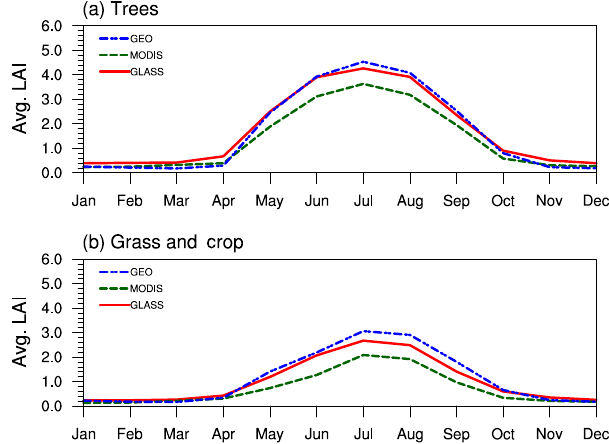
Figure 5. The monthly average leaf area index (LAI) values of (a) trees and (b) herbs in the three LAI products. Table 4. The simulation experiment configurations. E1 is the base- line experiment, and E1–E3 were used to investigate the impact of leaf area index inputs. The impact of different plant functional type (PFT) inputs was investigated by E1, E4 and E5. Land cover Leaf area index E1 (baseline) FROM GLASS v1.1 FROM GEO v2 FROM MODIS MCD15 MODIS MCD12Q1 GLASS v1.1 GLASS